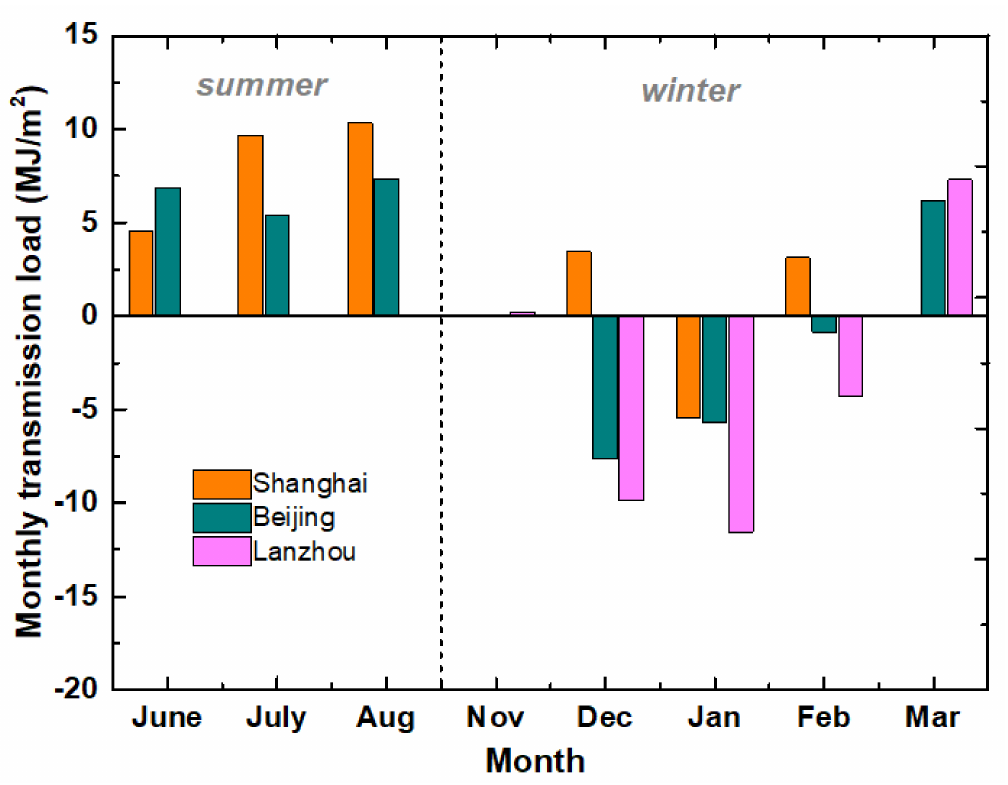
Figure 5. Monthly transmission load in three cities.